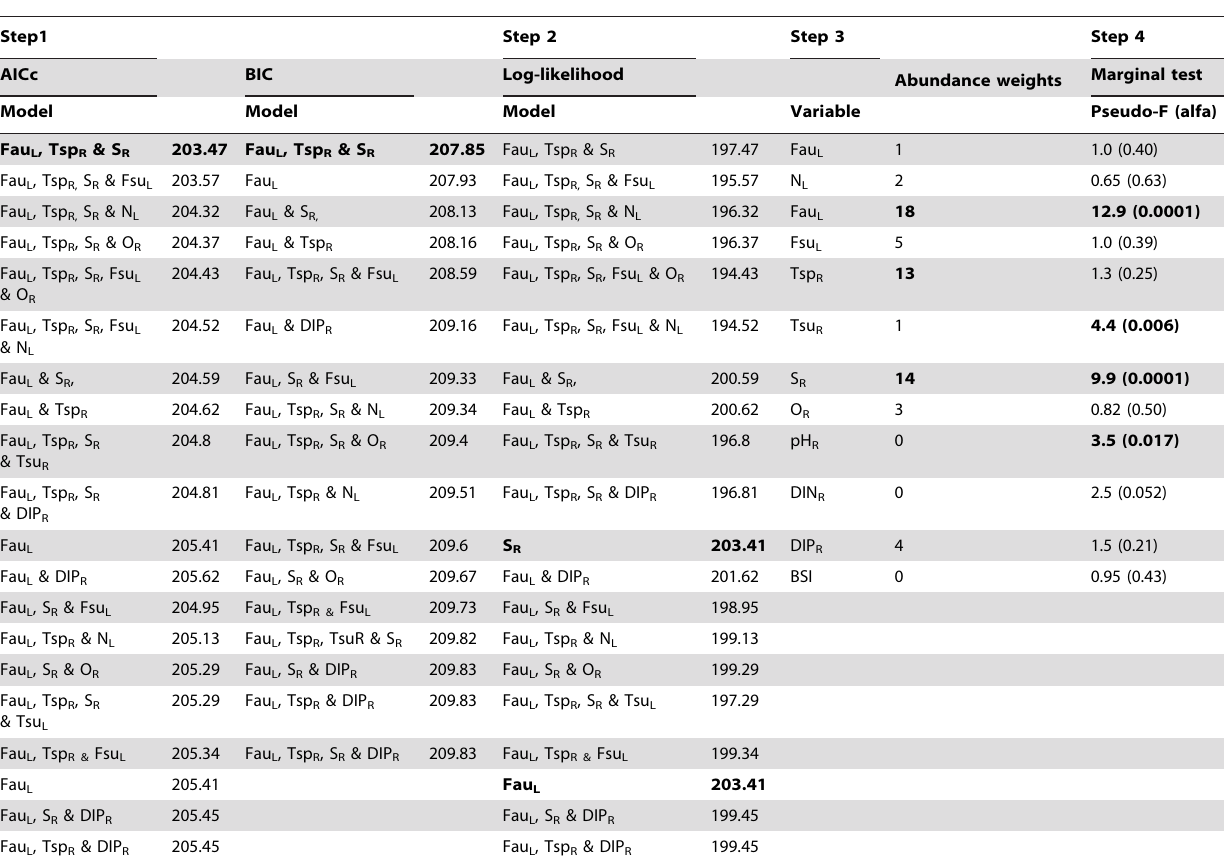
Table 4. Outcome of the DISTLM models for the Kva¨do¨fja¨rden data set.